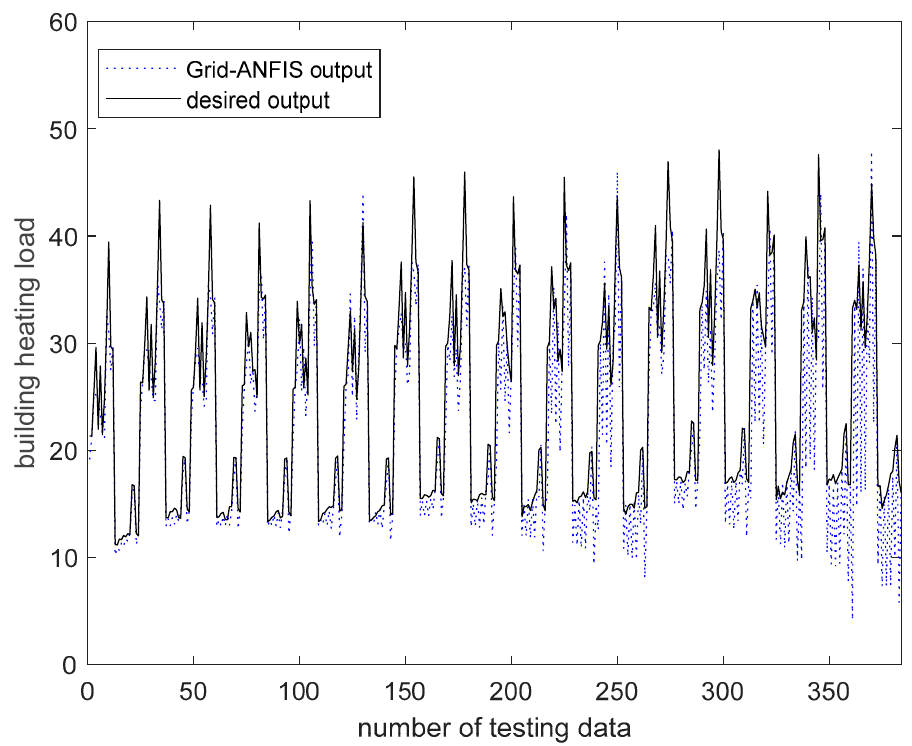
Figure 6. Comparison of the predicted and actual output values of grid-based ANFIS. Table 1. Prediction experiment results from grid-based ANFIS.